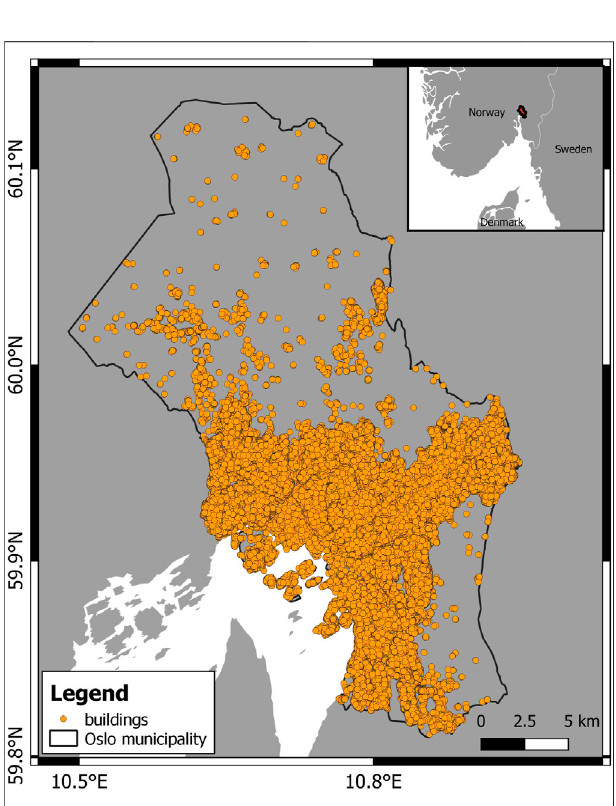
FIGURE 2 | Building distribution (shown with orange dots) in Oslo municipality (study